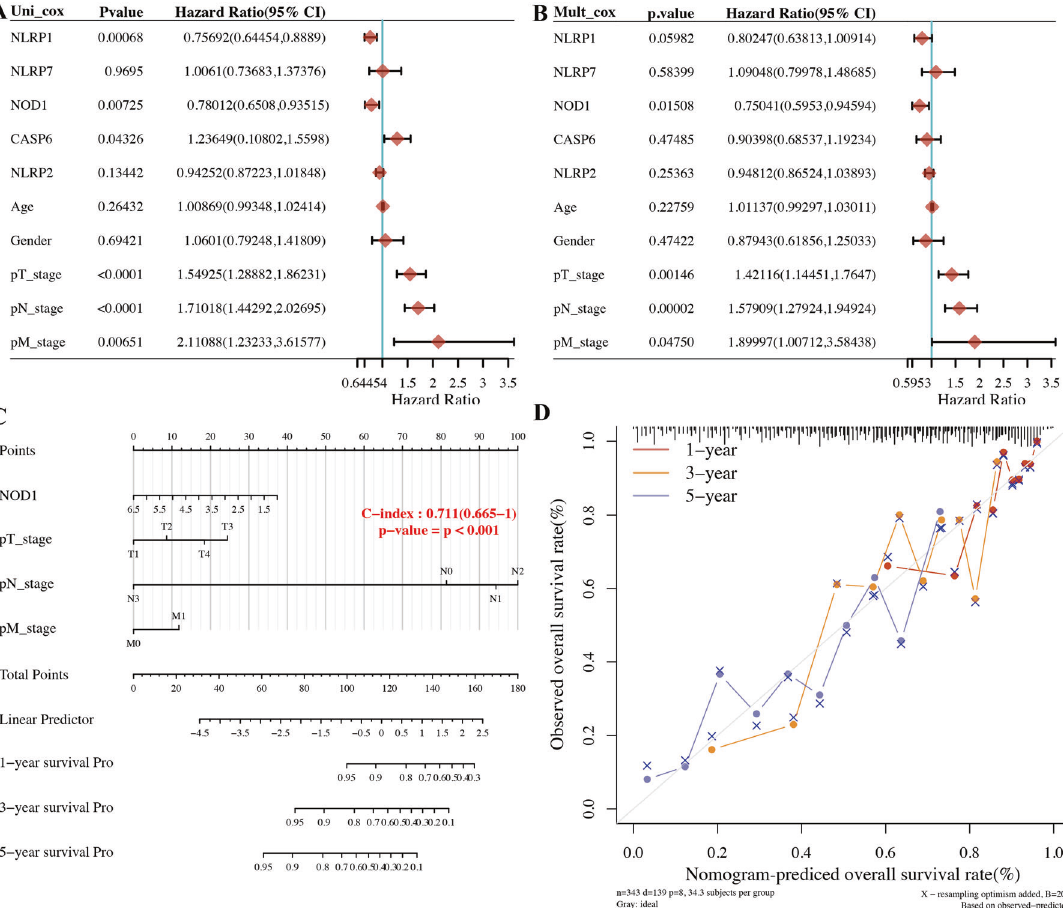
overall survival rate of LUAD patients. Calibration curve for the overall survival nomogram model in the discovery group. A dashed diagonal line represents the ideal nomogram. PRG pyroptosis ‑ related gene, LUAD lung